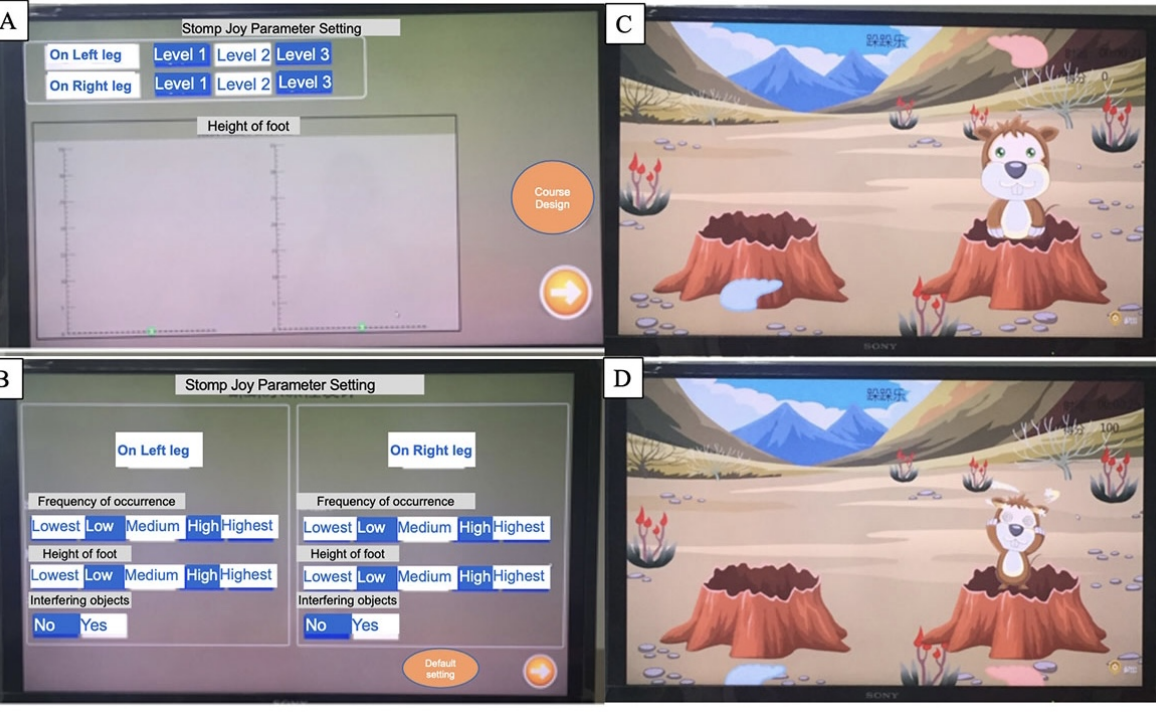
Figure 2. (A) The 3 difficulty levels for the left and right feet and the unique lifting foot height recognition interface. (B) The system-specific adjustment of the curriculum difficulty’s design according to patient conditions and default settings. (C) The patient raises their right foot, and when the hip and knee flexion reach the requirements of this level, the footprints above the gopher will turn from white to red. (D) When patients step down with the right foot, it shows an image of the gopher